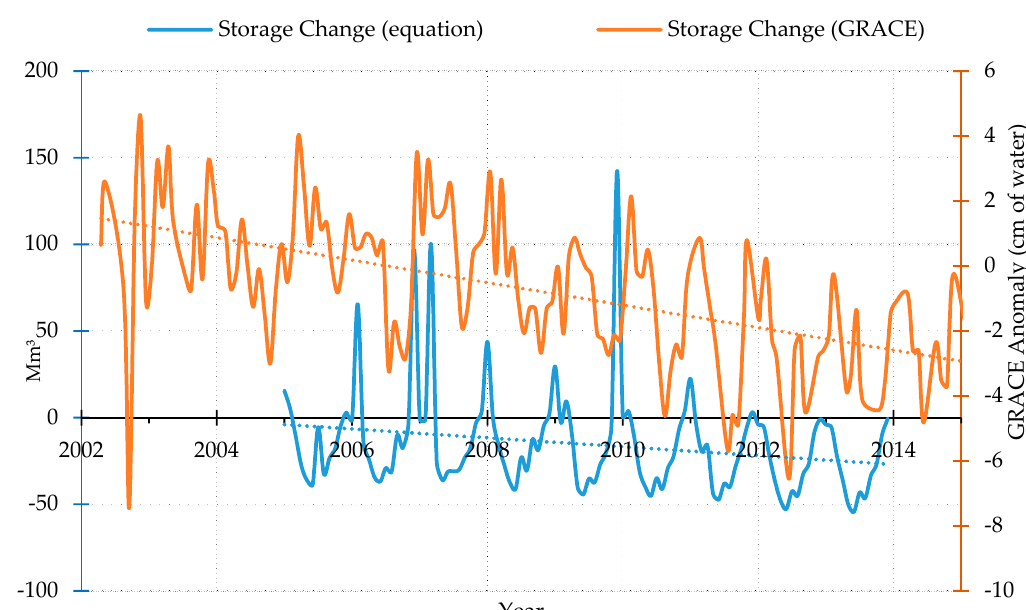
Figure 6. Variability of estimated water storage compared to gravity recovery and climate experiment (GRACE) anomalies (GRACE right axis).